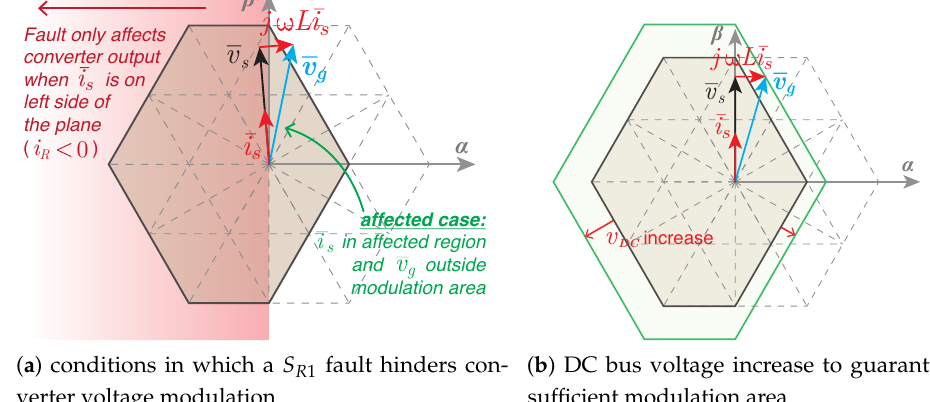
Figure 5. Conditions in which an outer IGBT fault (in S R 1 ) affects the GSC operation and proposed technique to ensure sufficient modulation area, with minimal DC bus voltage